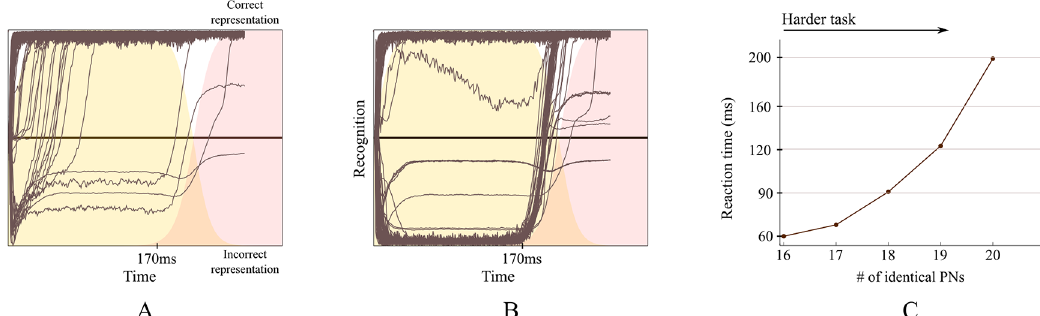
Fig 6. Performance of the model in difficult tasks. The connectivity matrix has two sequences which were similar to each other. (A-B) Each single line represents one trial (out of 100 trials) simulated from the model. The Y axis represents the recognition variable, which is calculated from the difference between the Euclidean distances from the observed KC activity to the correct one and from the observed KC activity to the incorrect one (see Eq 6 in Methods). If the KCs are displaying the correct representation (encoding the displayed odor), the corresponding line is near the top. If the KCs are displaying the incorrect representation (i.e. the other sequence stored in the system), the corresponding line is near the bottom. Lines near the middle are as close to the correct representation as to the incorrect one. The activity of the clusters in the expected (correct) sequence is in the plot background as a time reference to show that many single trials quickly jump to the correct representation after the second cluster in the sequence starts: The shaded areas (2 colors) represent two clusters in the sequence (as in Fig 5B). (A) Results for a task in which the PN data for the two stored sequences are very similar during the first cluster: Only three out of twenty PNs are different for the two sequences during the first cluster. Due to noise, the KC activity represents sometimes the incorrect odor for a brief period of time. (B) Results for a task in which the PN data for the two stored sequences are identical during the first cluster but dissimilar for the rest of the odor. During exposure to the first segment of the odor, the representations on the KCs are correct around 50% of the time, as expected, consistent with random chance. When the second cluster in the sequence begins (at ca. 170ms), the KC activity quickly jumps to the correct representation. (C) Average reaction time of 100 trials plotted against difficulty of the task (as defined with the number of PNs that belong to the representations of both odors; see Methods). The PN representations of the two stored sequences are similar during the first 170ms; afterwards, they diverge and become easily identifiable. The more similar the PN representations of two stored odors are during this initial period, the longer it takes the KCs to identify it. The maximum reaction time, around 200ms, corresponding to the case in B, is obtained when all 20 PNs are the same. The case in A corresponds to 17 identical